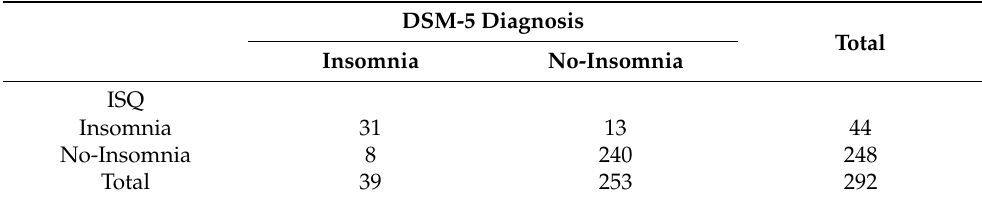
Table 4. Cross-tabulations between DSM-5 diagnosis and ISQ classifications of subjects (No-Insomnia and Insomnia).